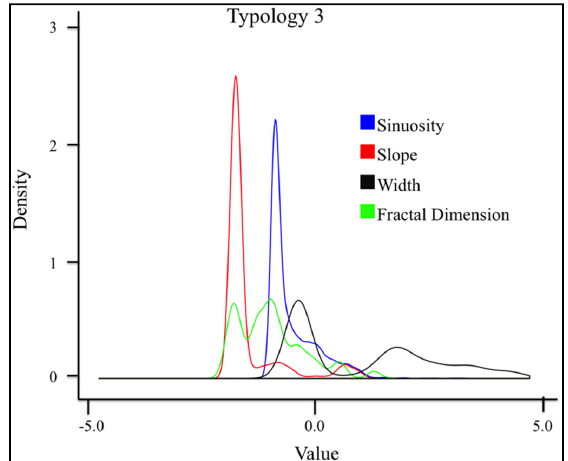
Figure 5. Density plot of the normalized values of channel sinuosity, slope, fractal dimension and width exemplified in Typology 3. Table 1. The qualitative contribution of variables to each typology, resulting from the principal component analysis. (–) = negative relationship, (+) = positiverelationship, (0) = no discernable relationship.